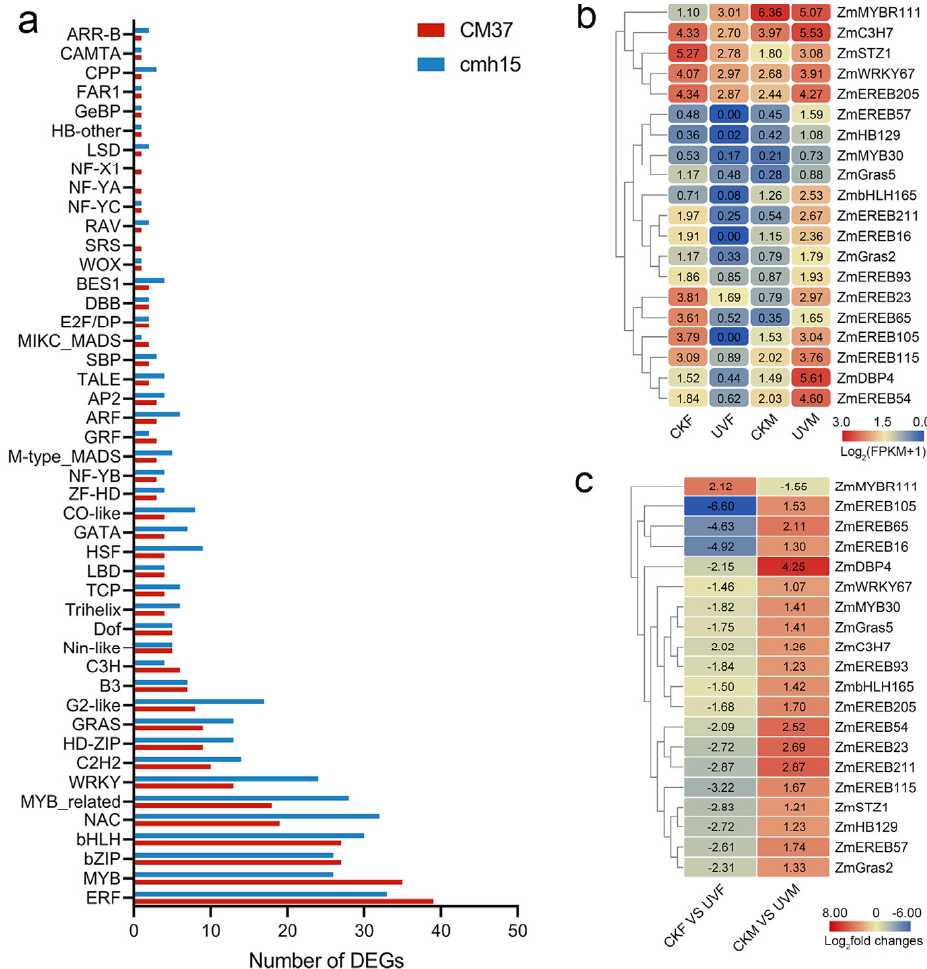
Figure 6. Transcription factors (TFs) encoded by DEGs detected in the CKM vs. UVM and CKF vs. UVF comparisons. ( a ) Classification and statistics of the TF families. (b, c) Heatmaps of the FPKM+1 values ( b ) and fold changes ( c ) of the 20 TFs that showed opposite regulatory trends in the two comparisons.